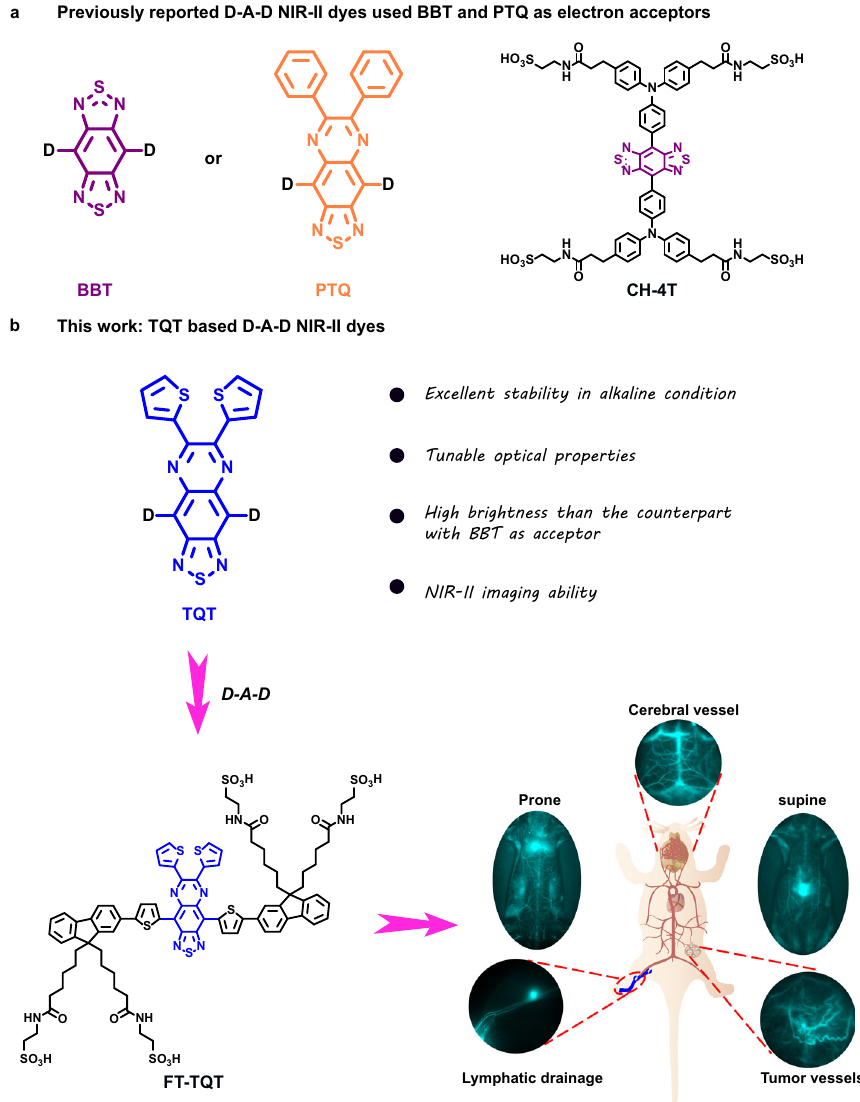
Fig. 1 Designing a new generation of NIR-II D-A-D dyes by acceptor engineering strategy. a Previous NIR-II D-A-D dyes used BBT and PTQ as electron acceptors; b D-A-D NIR-II fl uorophore structures of this work based on TQT